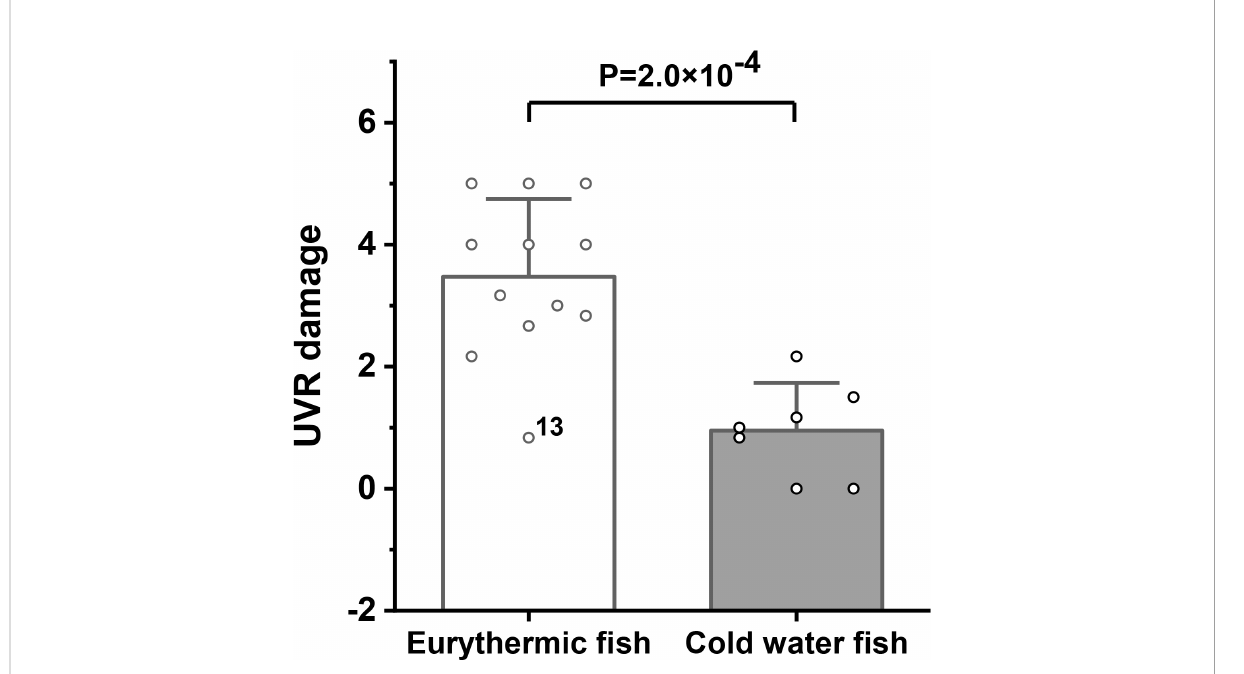
FIGURE 5 Comparison of UVR damage between eurythermal and cold water fi shes. The height and whiskers indicate the mean ±